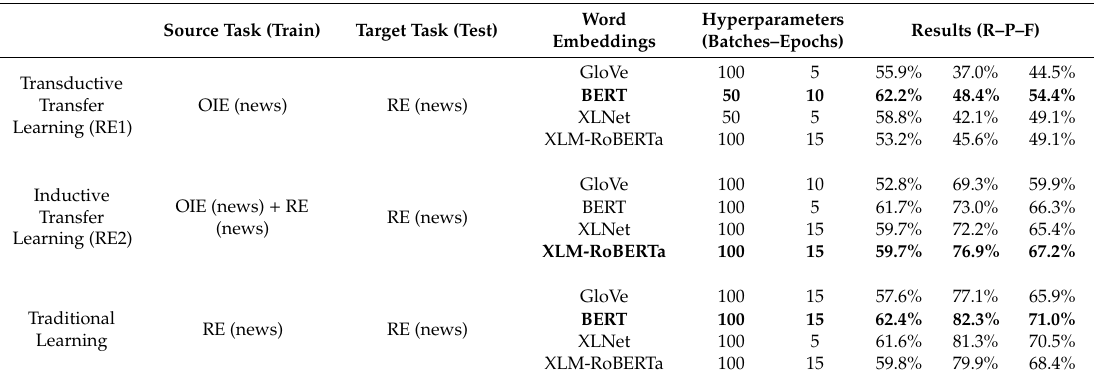
Table 8. Results of transferring from OIE to RE using four di ff erent word embeddings. Bold values indicate the highest achieved F-measure in each of the three experiments (transductive transfer learning, inductive transfer learning, traditional learning).